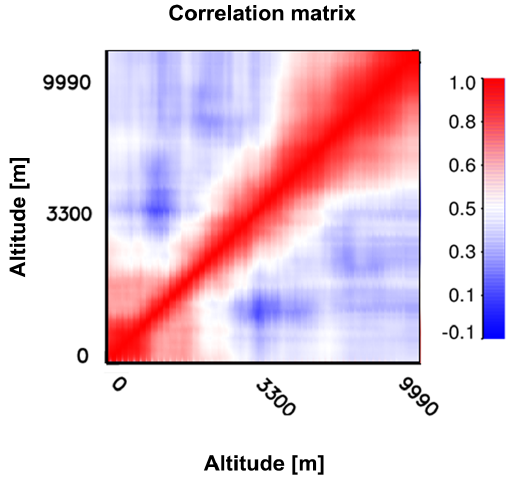
Figure 1. Correlation matrix derived from 217 radiosondes launched during HOPE. Correlation is shown for absolute humidity as a function of the altitude (from 0 to 10km above the